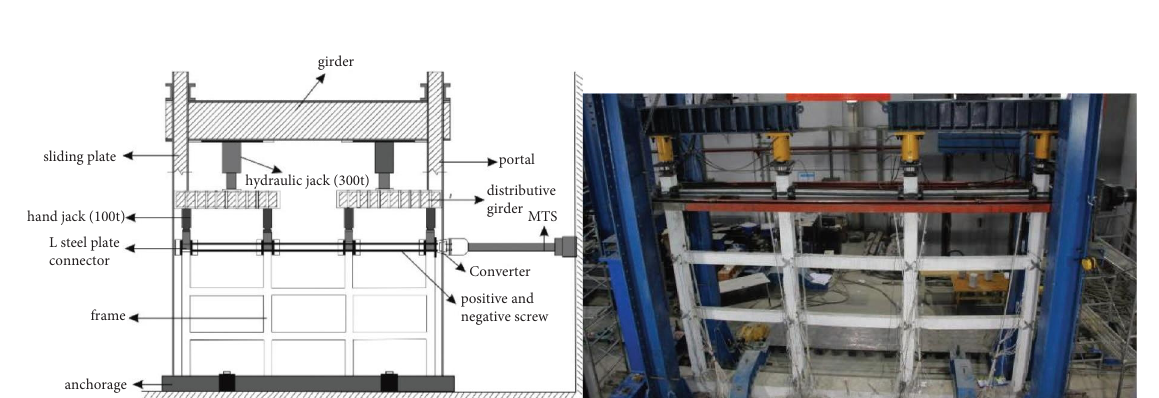
Figure 2: Schematic diagram of the test loading device.